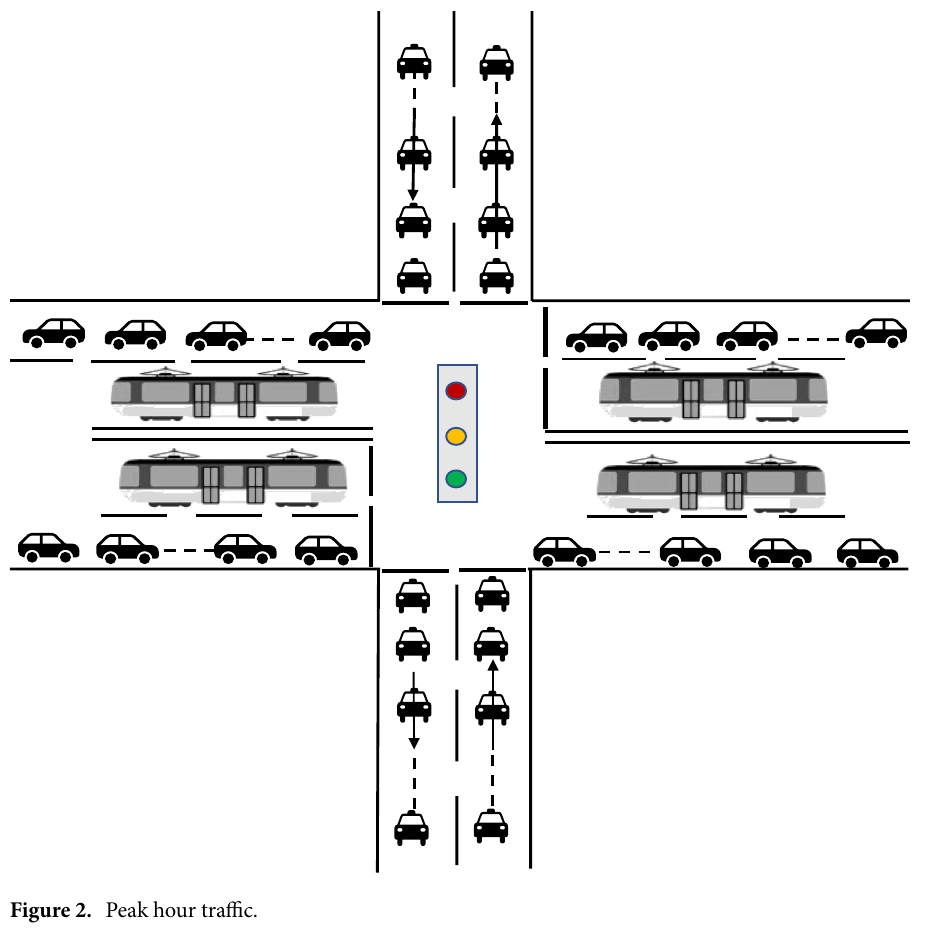
Figure 2. Peak hour